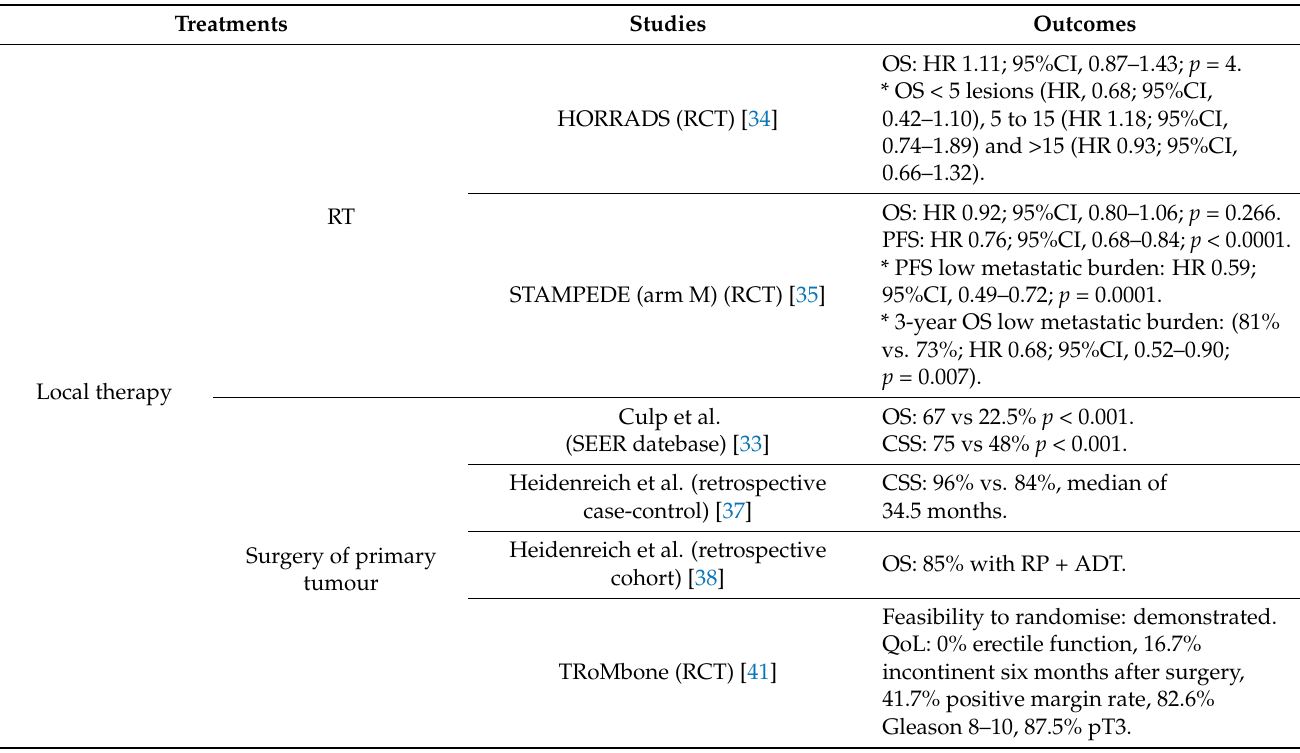
Table 2. Main studies in the treatment of oligometastatic prostate